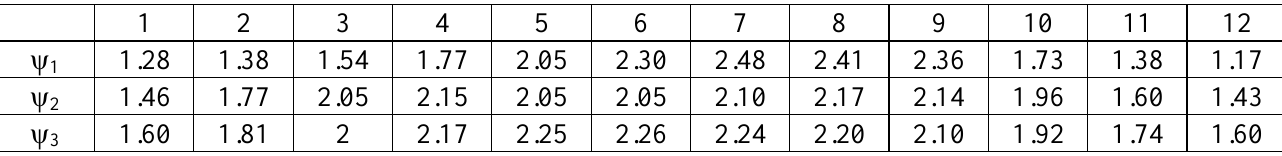
Table A- Seasonal factor by Reddy